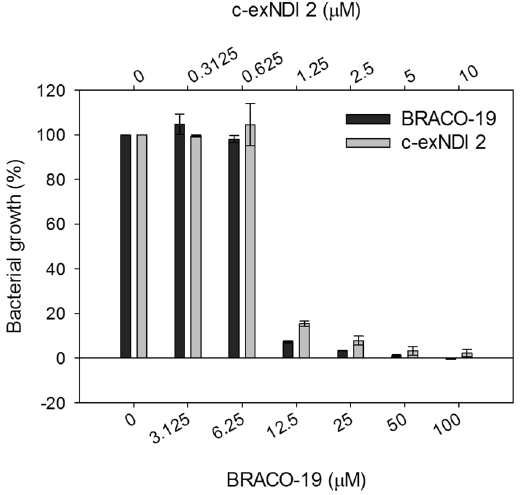
Figure 4. Resazurine Microplate Assay to measure the activity of different G4 ligands (BRACO- 19 and c-exNDI2) on Mtb